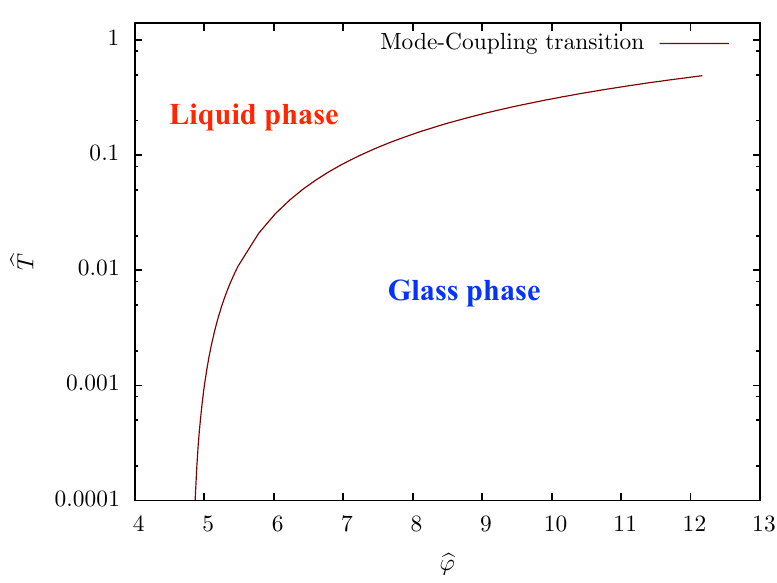
Figure 2: Phase Diagram of Harmonic Soft Spheres in the infinite dimensional limit. At zero temperature, the line converges to the Mode Coupling transition point of Hard Spheres at ϕ ∼ (cid:98) MCT